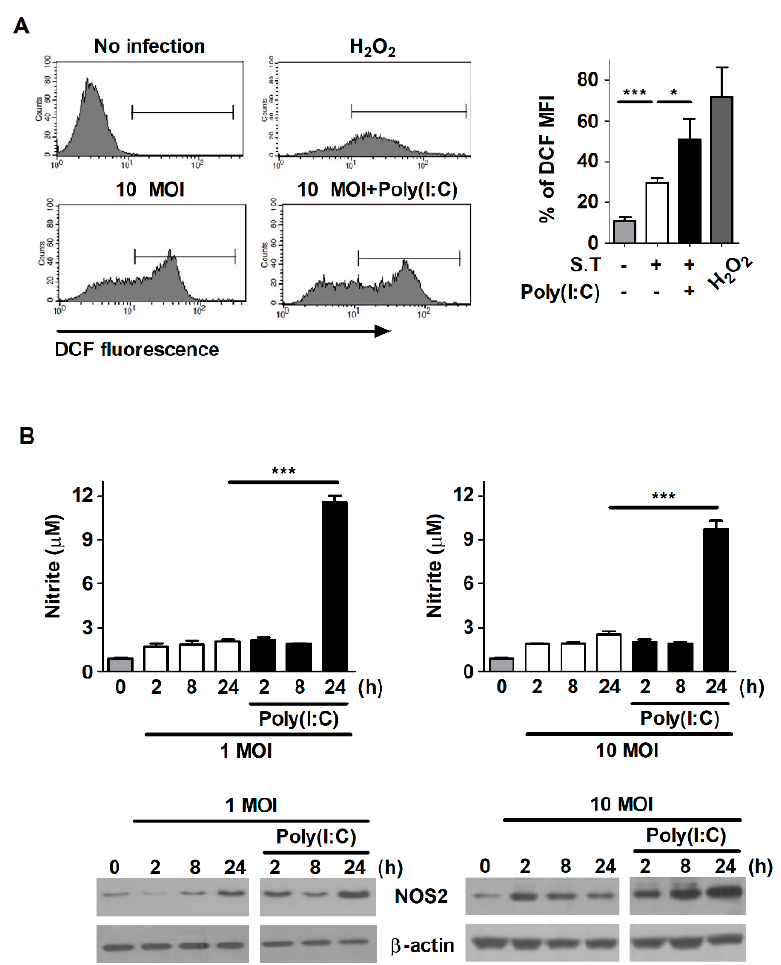
Figure 4. Poly(I:C) increases the production of ROS and NO in S . typhimurium-infected cells. ( A ) RAW264.7 cells were infected with S . Typhimurium at an MOI of 1 or 10 and then treated with poly(I:C) (10 μ g/mL) for 30 min. The cells were labeled with 5-[and-6]-chloromethyl-2 ′ ,7 ′ -dichlorodihydrofluorescein diacetate (DCFH-DA) and then measured via flow cytometry. The bar graph indicates the percentage of DCF mean fluorescence intensity (MFI). H 2 O 2 was used as a positive control. ( B ) RAW264.7 cells were infected with S . Typhimurium at an MOI of 10 and then treated with poly(I:C). NO production was assessed in cell culture supernatants at the indicated timepoints. Total cell lysates were assessed via Western blot analysis to detect the expression of iNOS. The data are presented as the mean ± SD ( n = 3), and were analyzed via one-way ANOVA followed by Tukey’s post hoc test for multiple comparisons; * p < 0.05 and *** p < 0.001.